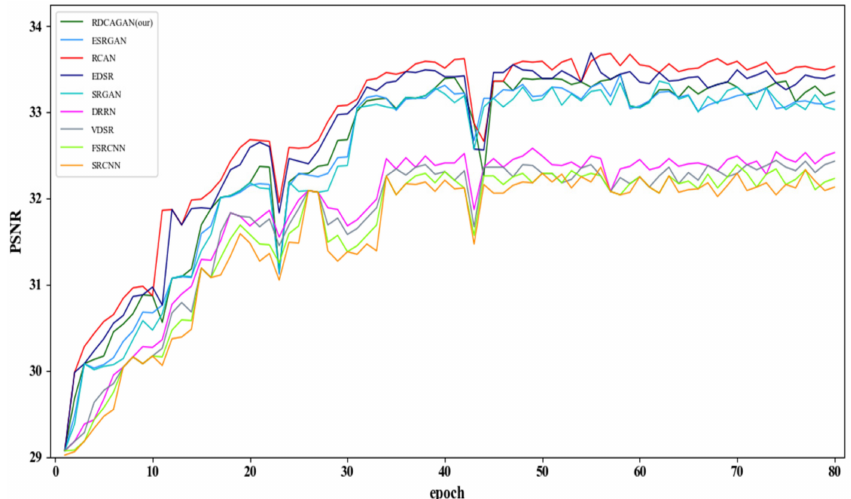
Figure 10. Comparison of PSNR generated SRCNN, FSRCNN, VDSR, DRRN, SRGAN, EDSR, RCAN, ESRGAN, and RDCA-SRGAN.